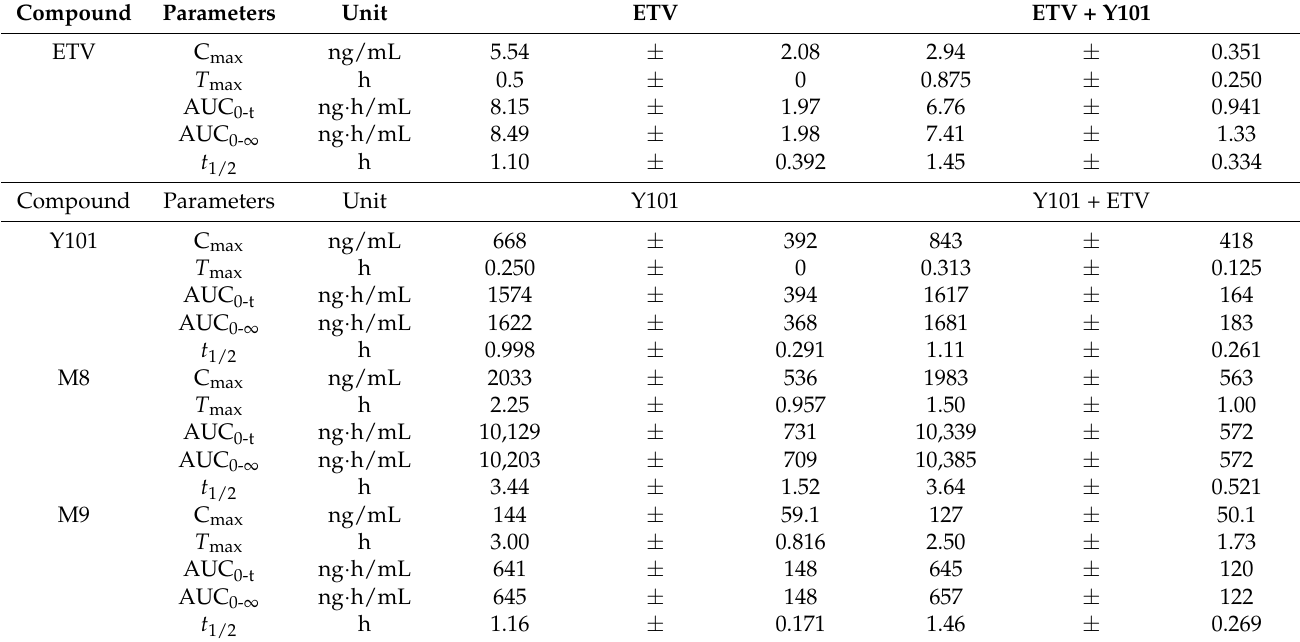
Table 3. Pharmacokinetic parameters of ETV, Y101, M8 and M9 after oral administration of Y101 (60 mg/kg) and Y101 + ETV (0.06 mg/kg). Data are expressed as mean ± SD ( n = 4).